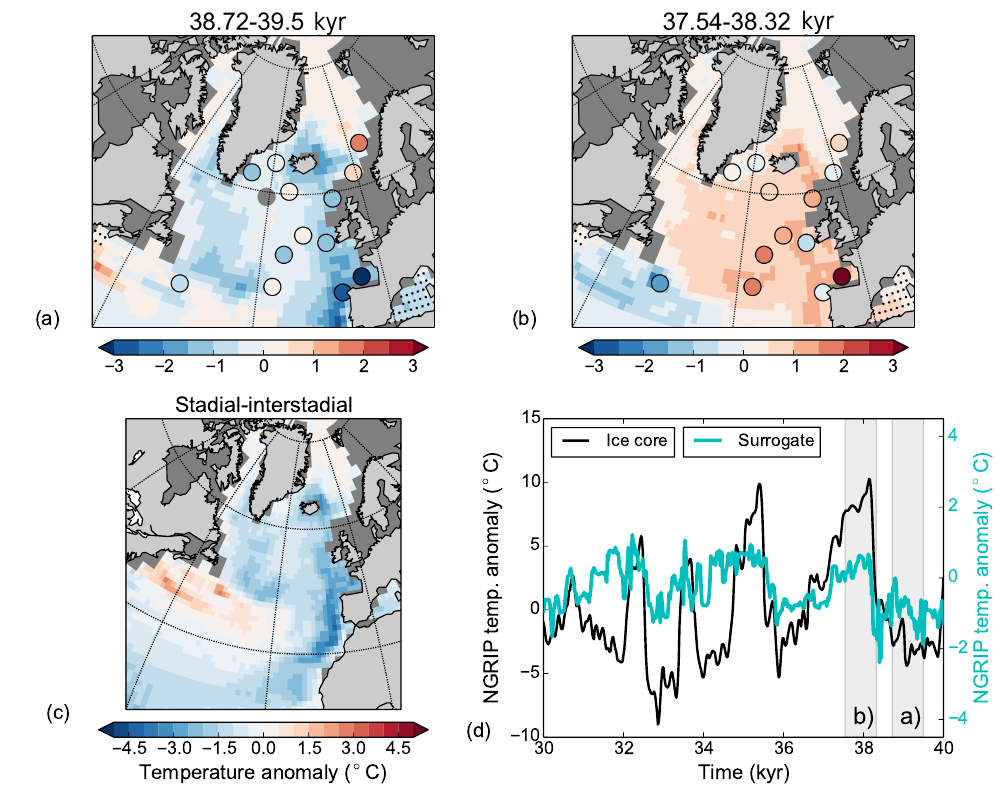
Figure 7. Temporal means of the spatial patterns for (a) end of GS9, (b) beginning of GI8, and (c) the GS9–GI8 difference. Background color shows the temperature anomalies from the surrogate reconstruction, while colors in circles indicate temperature anomalies from the proxy data (missing values for core 5 in the time period of panel (a) . Black (yellow) dots mark points where the surrogate reconstruction using the original age models are not within the 90% confidence level using age offsets of 500 years (dropping each core, all values within). Panel (d) shows reconstructed NGRIP temperatures from the ice core (black line, right y axis; Kindler et al., 2014) and the values from the surrogate time series (blue; note different y axis). The surrogate reconstruction is made using the same analog years which were picked for the SST reconstruction. The grey vertical shadings show the time periods used in the other panels.